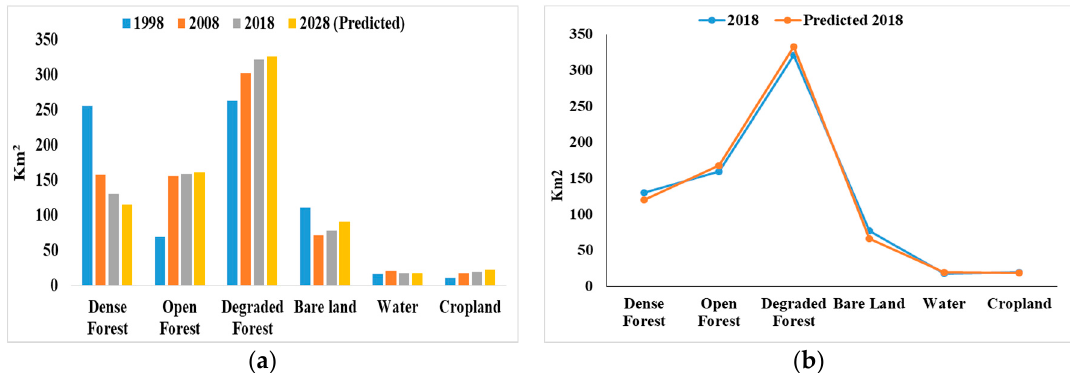
Figure 6. ( a ) Area Statistics (km 2 ) of the Land Use and Land Cover (LULC) classes for the years 1998, 2008, 2018, and predicted 2028. ( b ) Area Statistics (km 2 ) of 2018 versus predicted